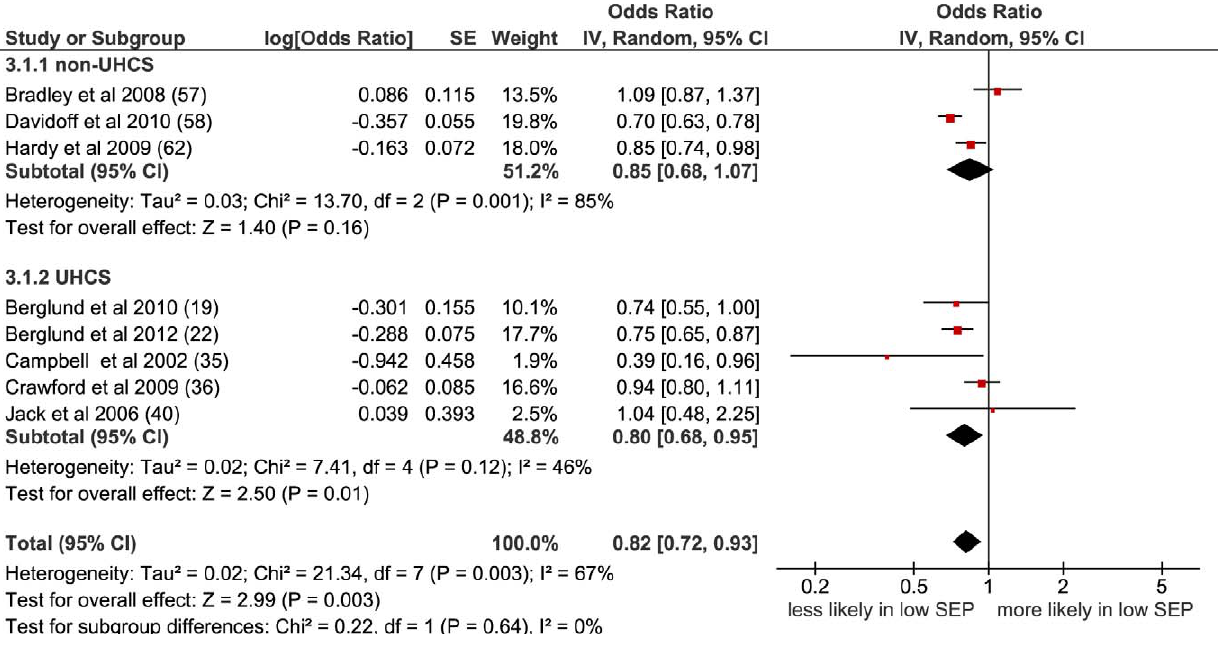
Figure 3. Meta-analysis of odds of receipt of chemotherapy in low versus high SEP. CI, confidence interval; non-UHCS, non-universal health care system; OR, odds ratio; SE, standard error; SEP, socioeconomic position; UHCS, universal health care system.